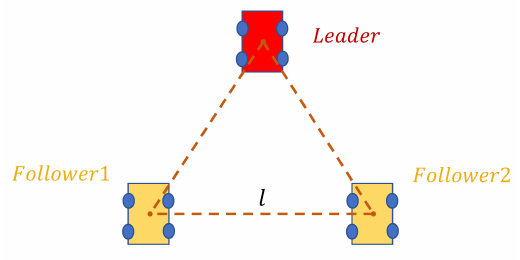
Figure 12. The basic single-layer triangular formation for